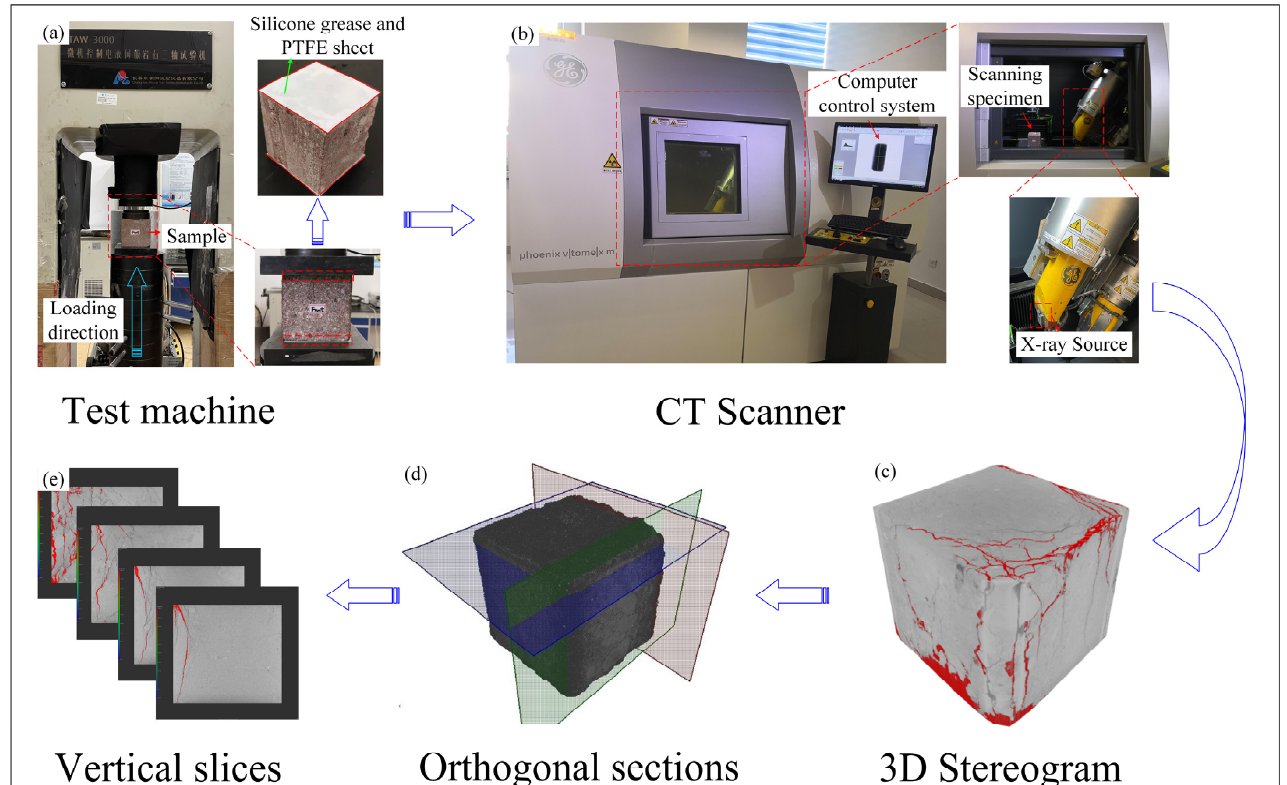
Figure 4. Experimental equipment and key flow diagram. ( a ) The specimens were tested with a uniaxial press after they were pre-treated. ( b ) The specimen was taken into the CT machine for scanning after it had been loaded and unloaded. ( c ) The 3D reconstructed model of the specimen was obtained after a series of processing of the rock images from the CT scan. ( d ) Slices in different directions can be selected by using the intercepted plane work of the software. ( e ) Intercepted sections of the specimen in the vertical direction for analysis.